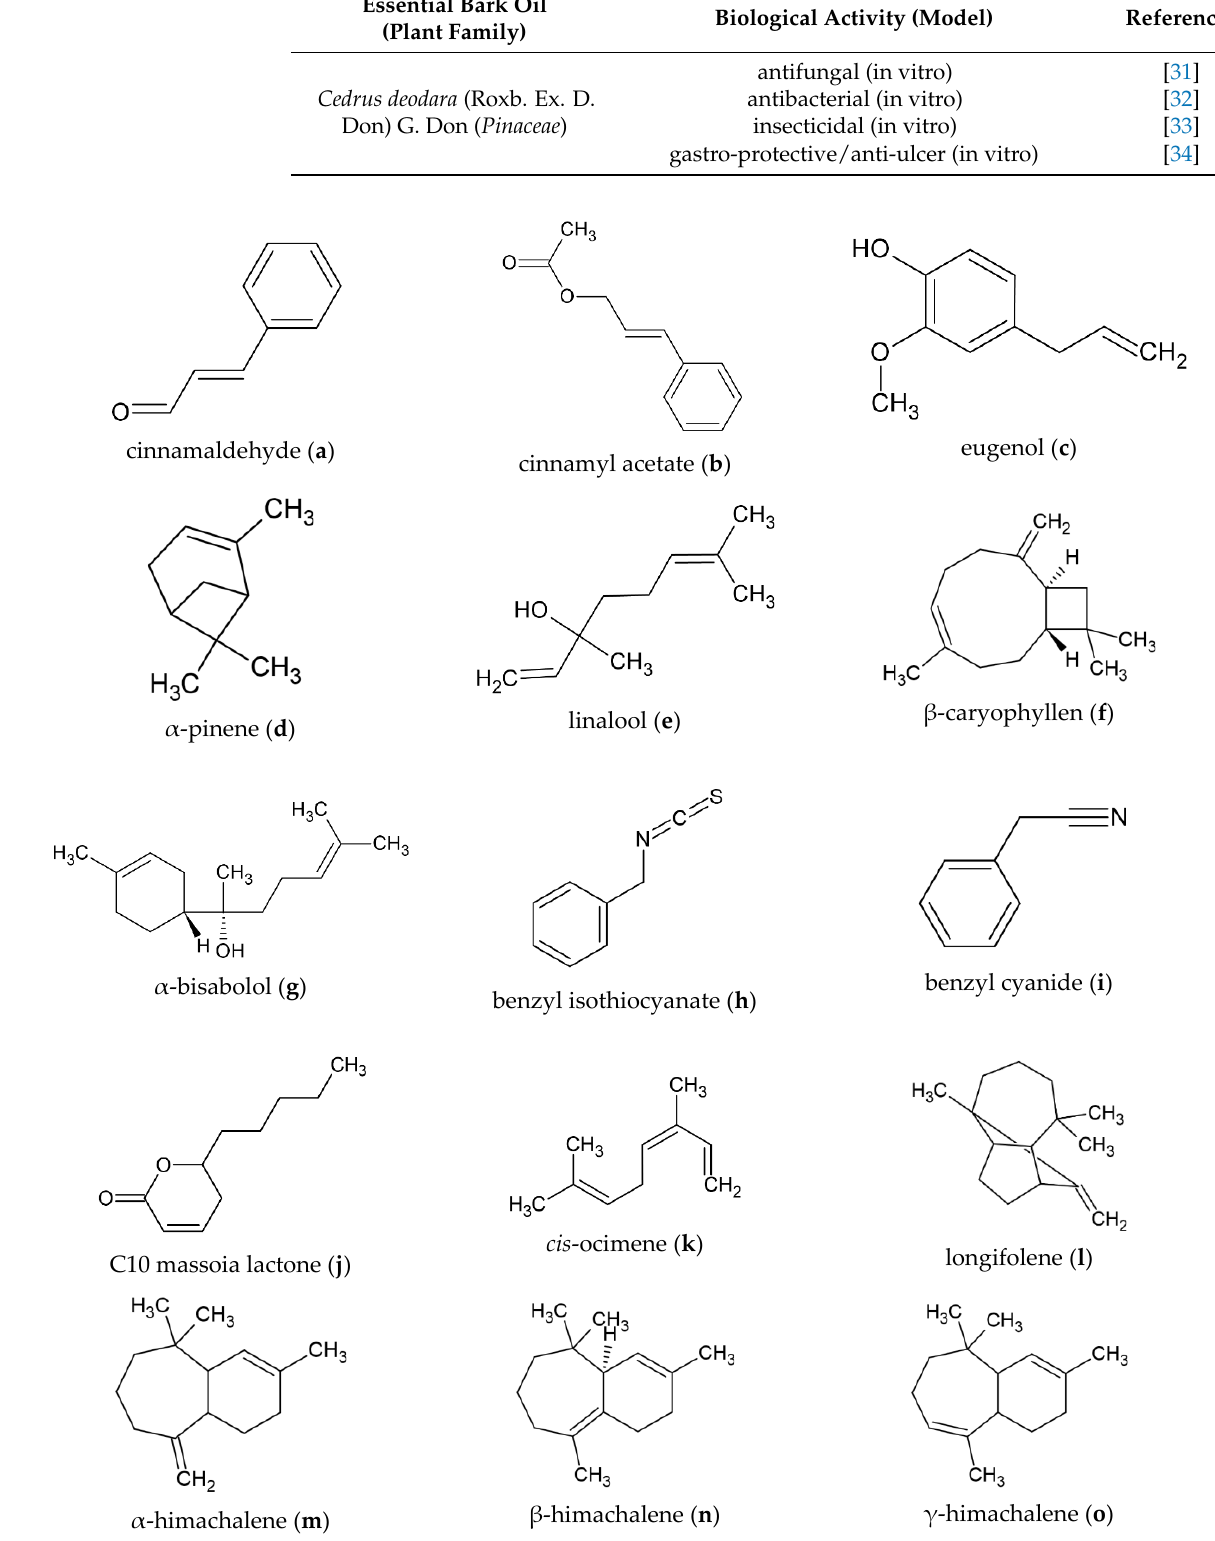
Figure 1. Chemical structures of principal constituents of selected barks and wood. Table 1. Major biological activities of selected bark EOs.